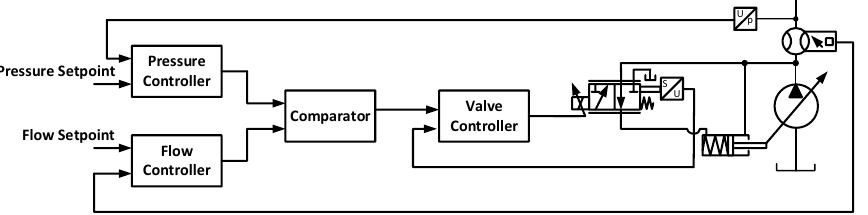
Figure 3. Hydraulic circuit diagram of a test rig for investigation of the axial piston pump.